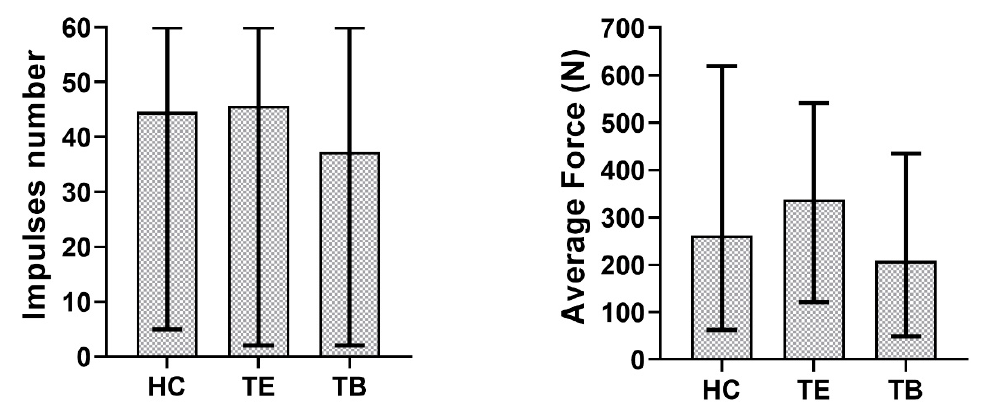
Figure 8. Cement influence on impulses number and average force.